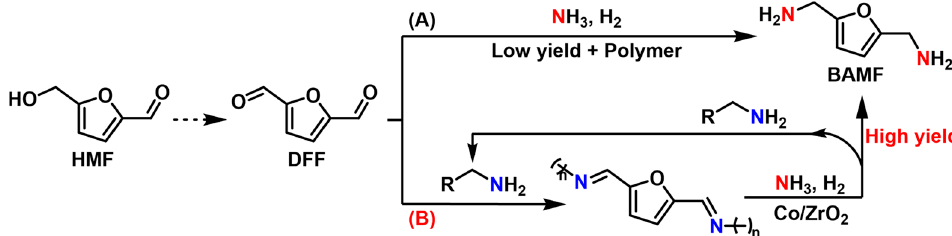
Figure 7. Reductive amination of DFF with NH 3 or butylamine. Adapted with permission from ref. [27]. Copyright 2020 Royal Society of Chemistry.